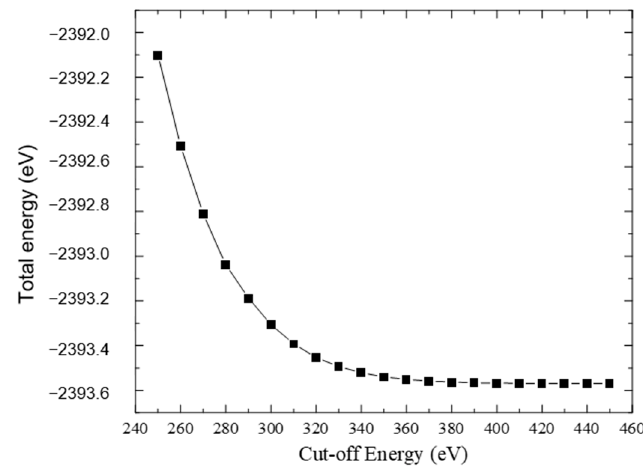
Figure 1. The cut-off energy of the plane wave convergence test.